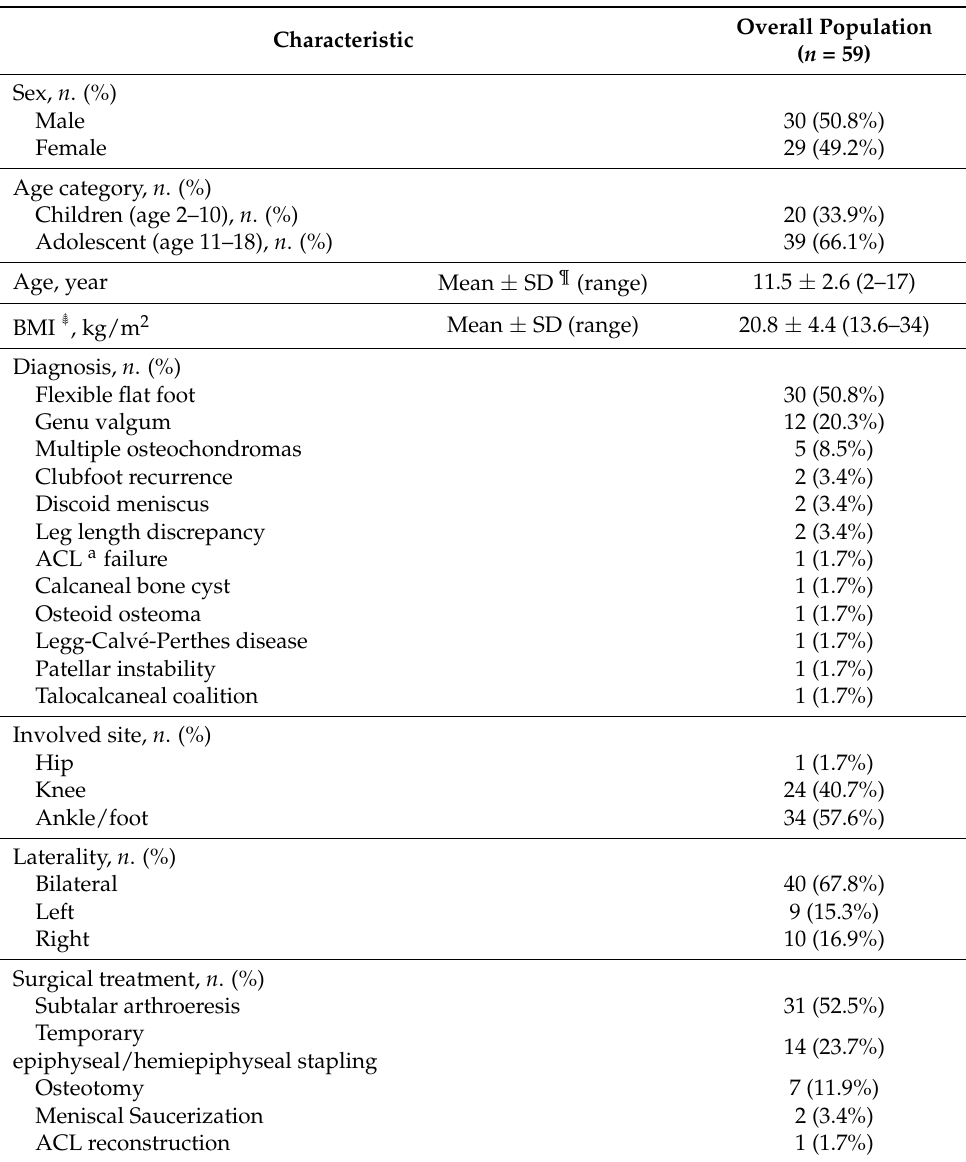
Table 1. Patient demographics and clinical characteristics.